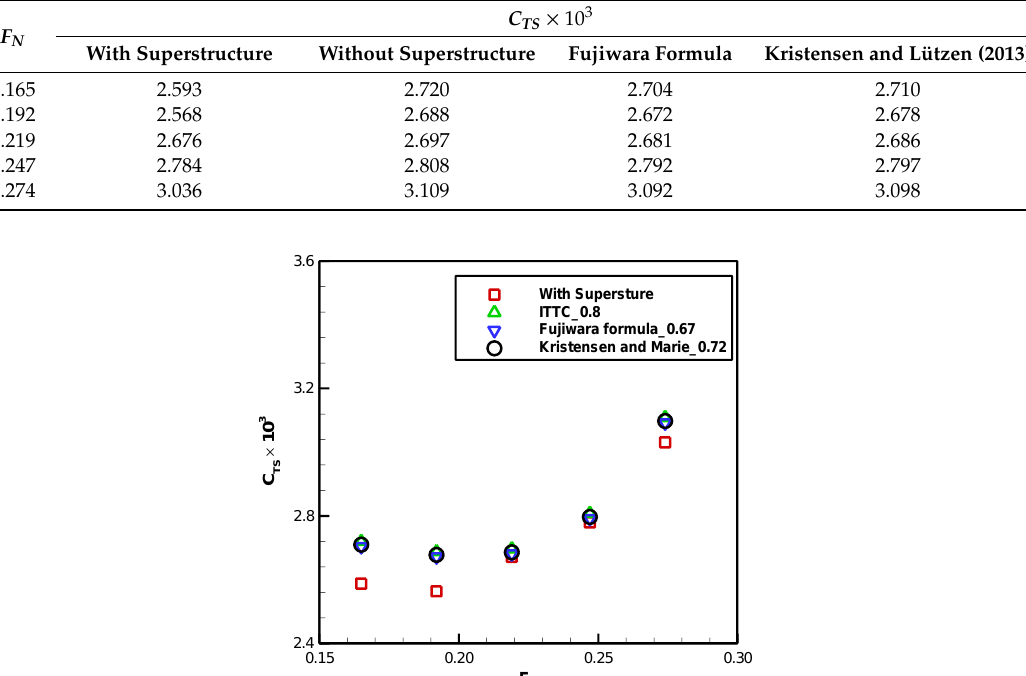
Table 8. Non-dimensional parameters for calculating the Fujiwara formula. Table 10. The total resistance coe ffi cient according to C DA .